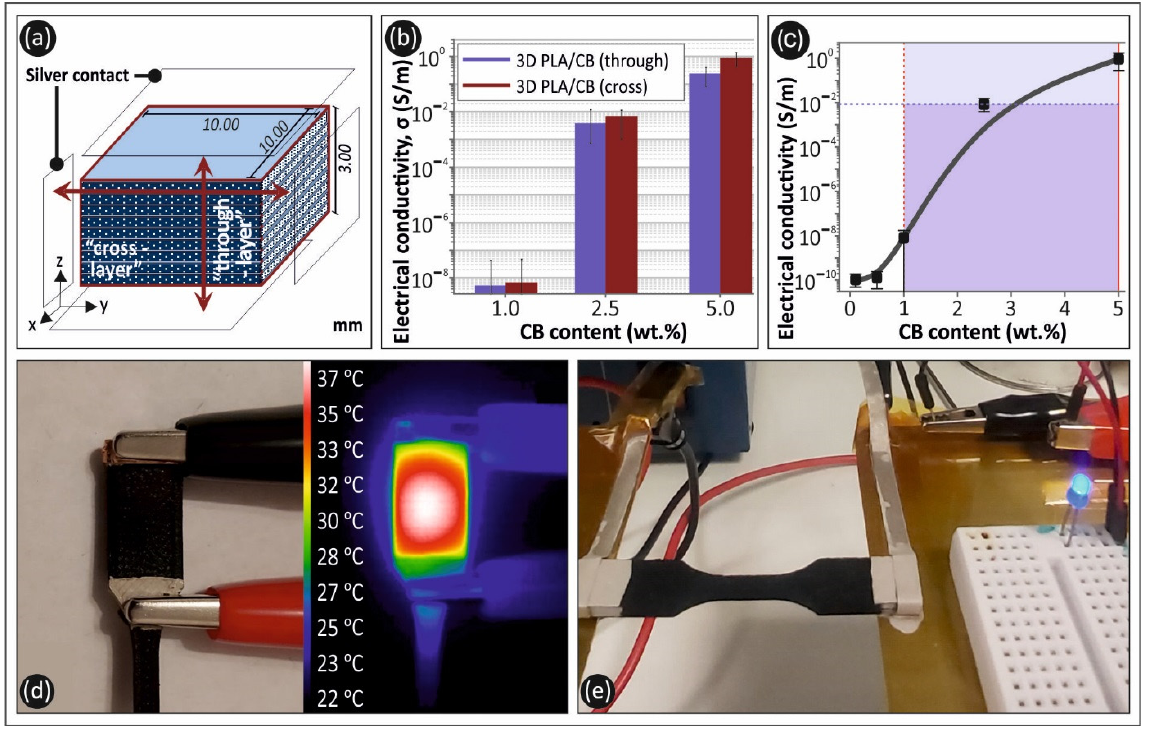
Figure 6. ( a ) schematic illustration of the electrical conductivity measurements for the 3D printed PLA/CB CPC specimens at two different directions; ( b ) electrical conductivity of the 3D printed conductive nanocomposites at 1.0, 2.5 and 5.0 wt.% CB content (at two different measurement directions; namely the “through layer” and the “cross-layer”), as well as ( c ) a detailed plot of the PLA/CB electrical conductivity at various filler loadings (0.1, 0.5, 1.0, 2.5 and 5.0 wt.% CB filler content), demonstrating the PLA/CB CPC percolation curve; ( d ) a real sample digital image (with the two deposited electrodes), as well as an IR-T image showing the electrothermal Joule heating performance of the PLA/CB (5.0 wt.%) nanocomposite at an applied DC Vbias of 15V; ( e ) LED in operation when current is passing through a PLA/CB (5.0 wt.%) nanocomposite in a closed circuit applying a Vbias of 15V.